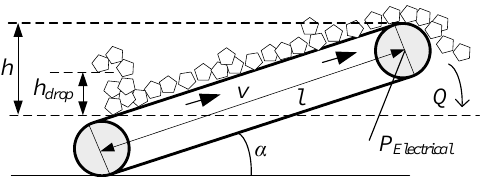
Figure 2. The working principle of a conveyor lifting material [16].